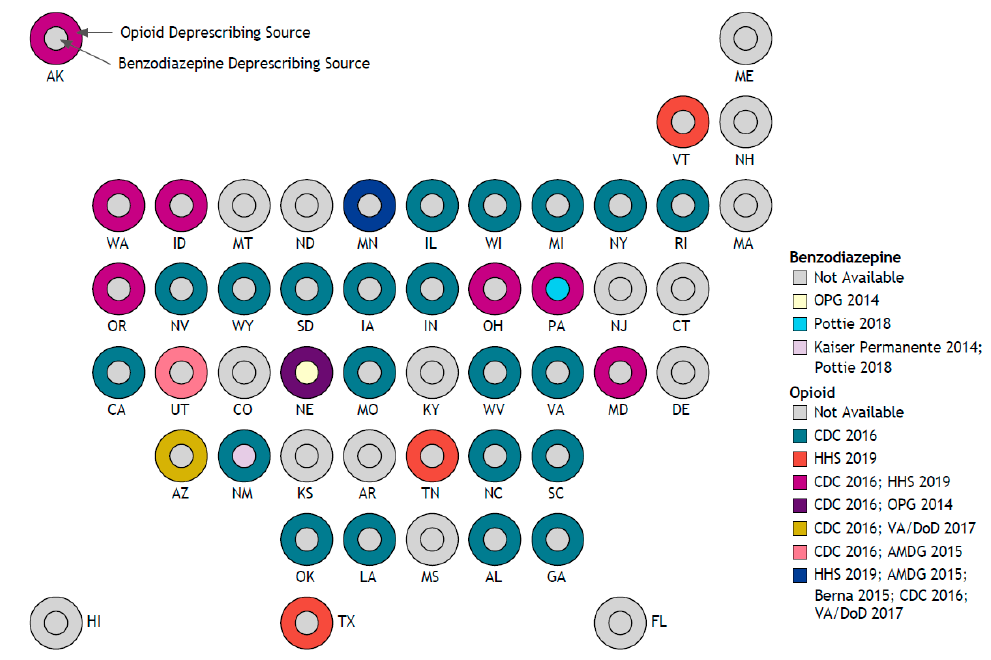
Figure 2. Deprescribing sources of opioid and benzodiazepine by